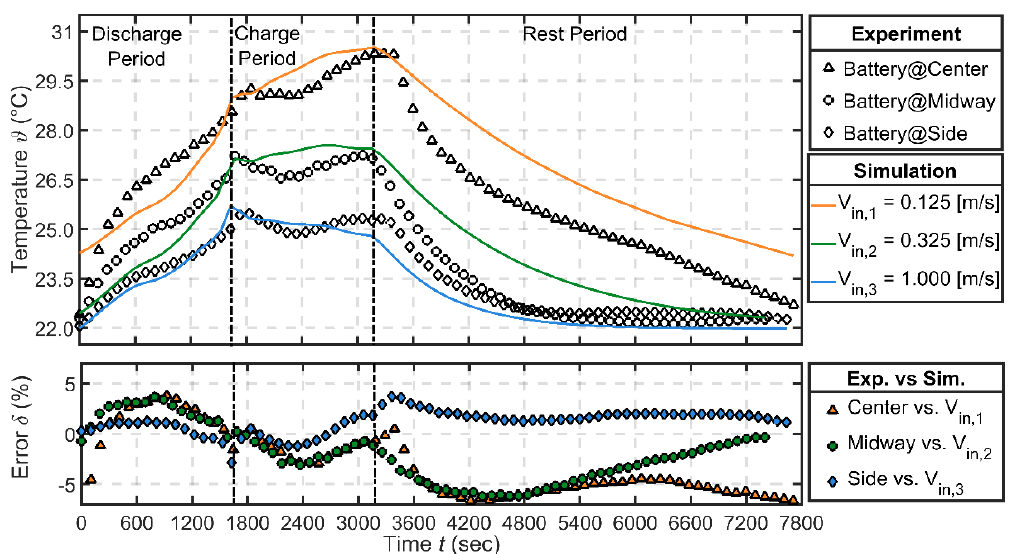
Figure 8. Experimental temperature curves 𝜗 (°C) of three similar battery cells at different locations within the battery test setup, simulated temperature curves 𝜗 (°C) at three different fluid flow inlet magnitudes 𝑉 𝑖𝑛 (m s −1 ) and the relative error 𝛿 (%) between experimental and simulated results are shown as a function of time 𝑡 (sec) . The reader is referred to Figure 5 for a closer look on the test conditions.